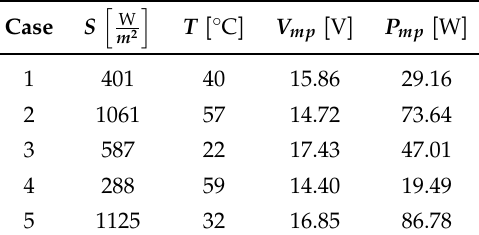
Table 6. Optimal operating voltage ( V mp ) and power ( P mp ) for different irradiances (S) and temperatures (T).